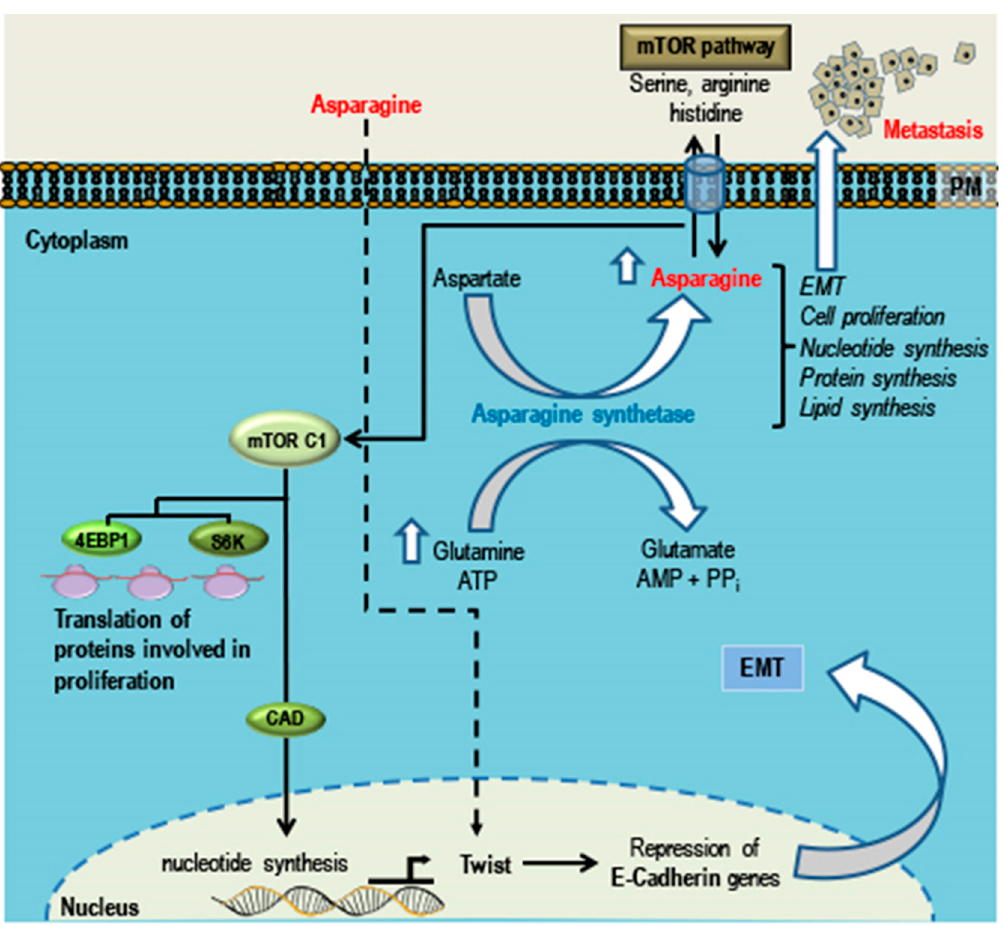
Figure 5. Role of asparagine in promoting growth, EMT, and metastasis in TNBCs. Asparagine, a non-essential amino acid, is synthesized in the body from aspartate in the presence of asparagine synthetase. Asparagine can act as an amino acid exchange factor regulating the uptake of other amino acids such as arginine, histidine, and serine into the cell. This amino acid exchange increases protein and nucleotide synthesis through the activation of mTORC1, which in turn favors and promotes TNBC cell proliferation. Increase in the bioavailability of asparagine (from dietary asparagine and the asparagine synthesized by the body) leads to an upregulation of EMT-up genes and asparagine-enriched EMT proteins (such as Twist1) with a decrease in the levels of E-cadherin, thereby promoting epithelial-mesenchymal transition (EMT) and supporting TNBC metastasis.